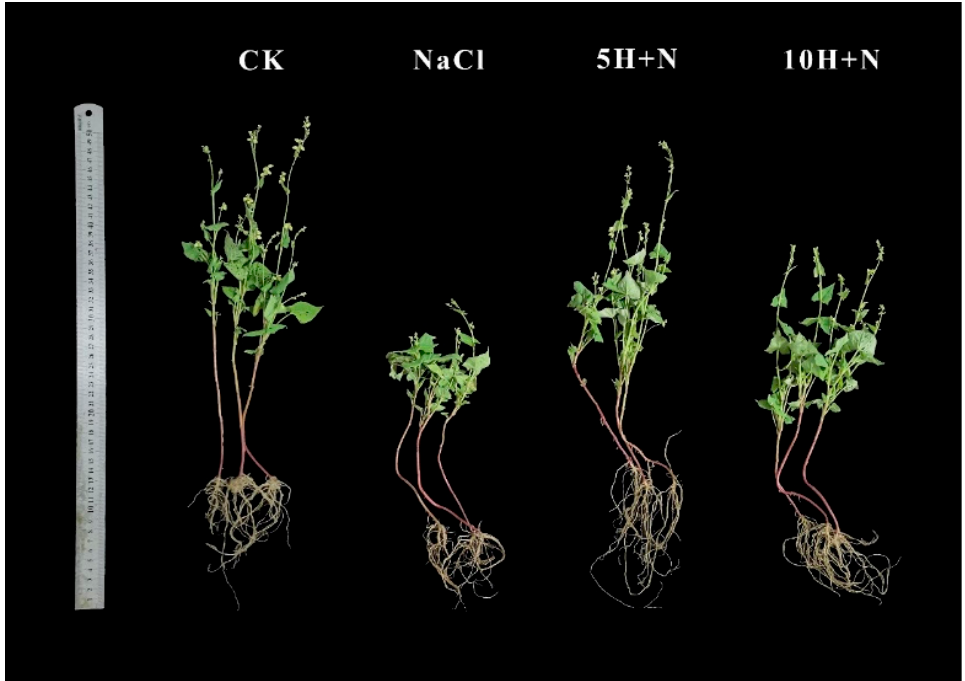
Figure 1. Effects of exogenous H 2 O 2 on growth of Tartary buckwheat under NaCl stress. The photos were taken on the 40th day of transplanting. CK: control, H 2 O foliar spray + H 2 O irrigation, NaCl: H 2 O foliar spray + 150 mmol · L − 1 NaCl irrigation, 5H + N: 5 mmol · L − 1 H 2 O 2 foliar spray + 150 mmol · L − 1 NaCl irrigation, 10H + N: 10 mmol · L − 1 H 2 O 2 foliar spray + 150 mmol · L − 1 NaCl irrigation. Under NaCl stress, plant height (PH), stem fresh weight (SFW), stem dry weight (SDW), root fresh weight (RFW), and root dry weight (RDW) of Tartary buckwheat were significantly decreased by 28.22%, 51.90%, 44.63%, 59.60%, and 48.19%,